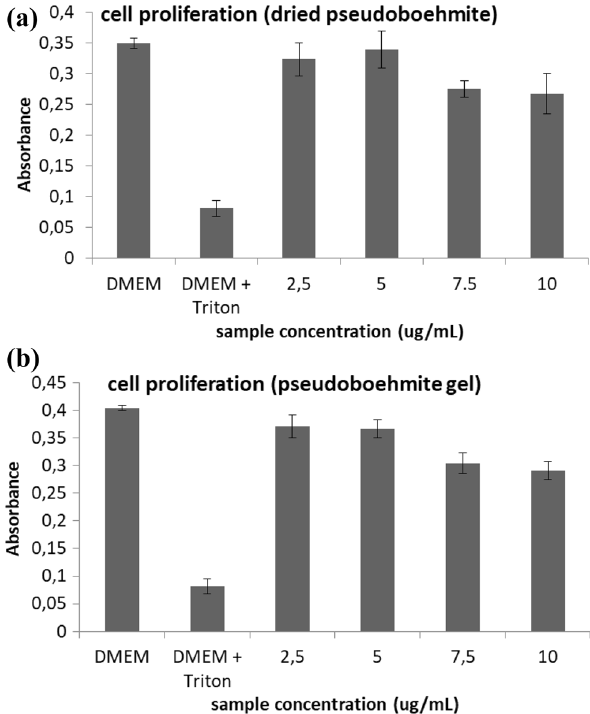
Figure 10. Results of pseudoboehmite gel toxicity using Caco-2 cell line (ATCC) for the ( a ) dried sample and the ( b ) pseudoboehmite gel.